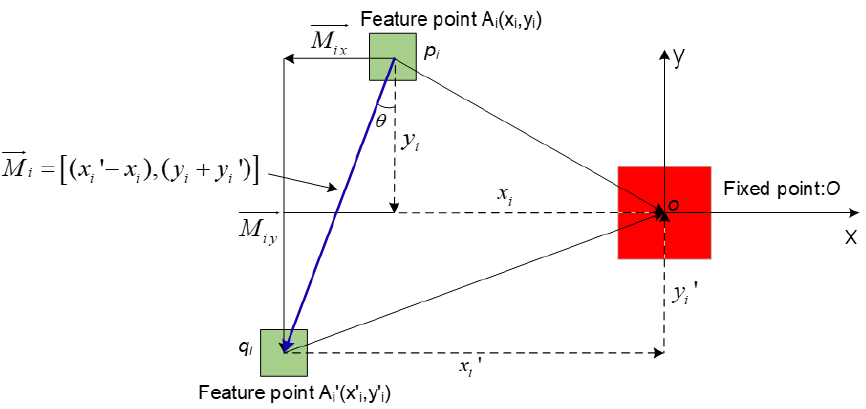
Figure 3. Mathematical model of the relative position change of the feature points.